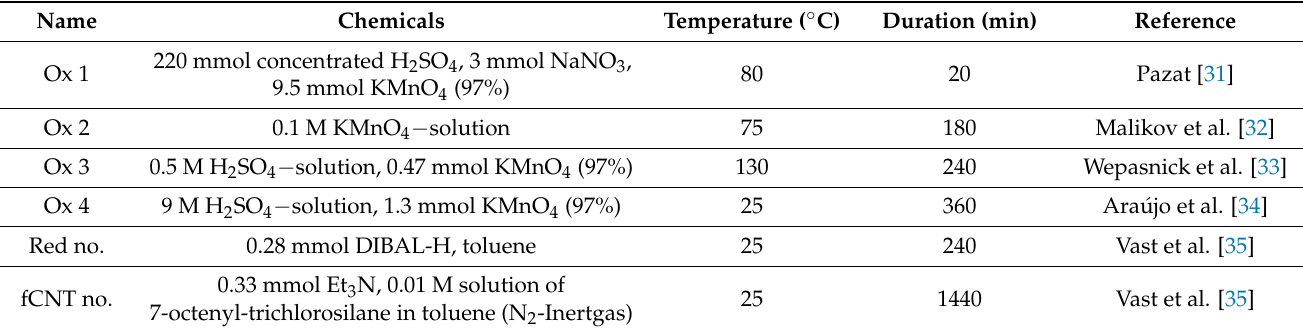
Table 1. Applied oxidation, reduction, and functionalization steps in